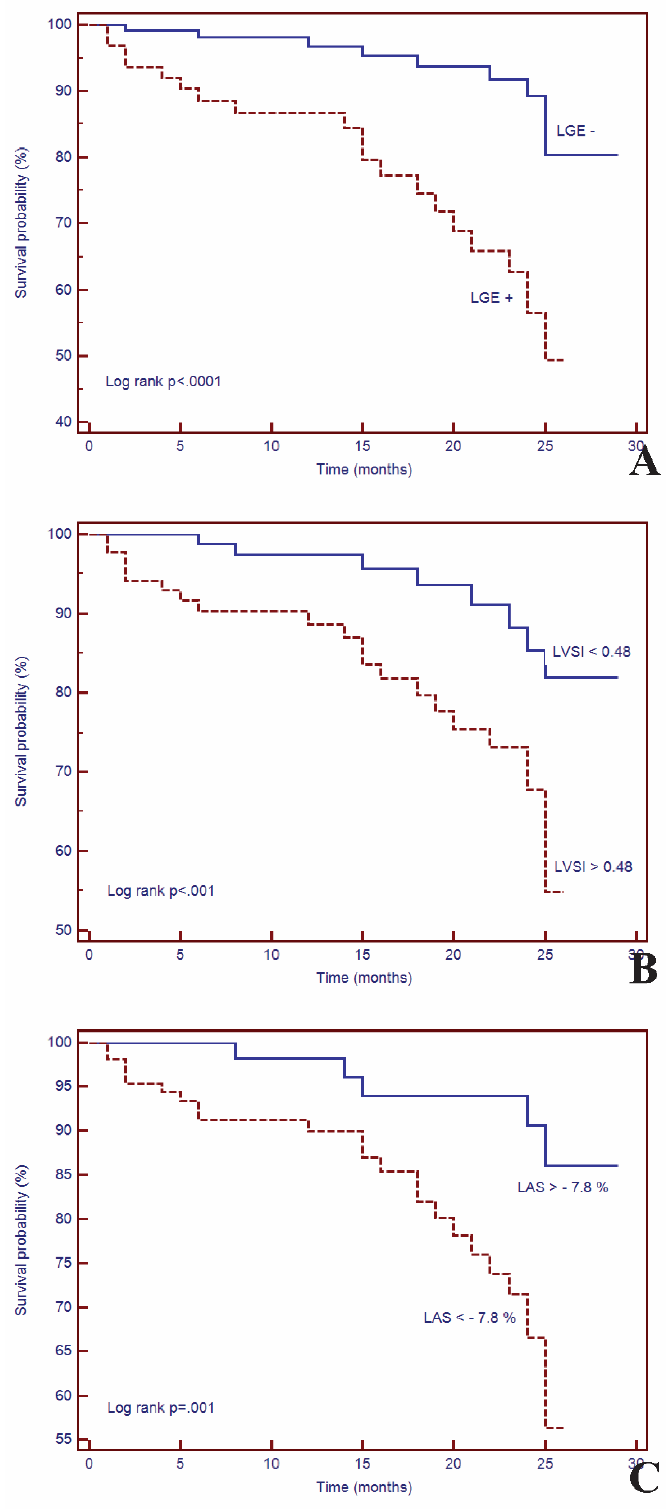
Figure 3. Kaplan–Meier curves for event-free survival for ( A ) LGE+, ( B ) LAS, ( C ) LVSI. Abbreviations: LAS, long axis strain; LGE, left ventricular late gadolinium enhancement; LVSI, left ventricular sphericity index.